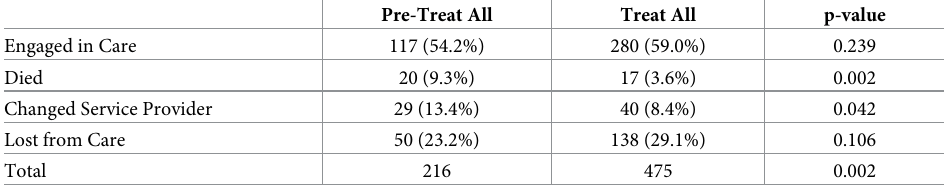
Table 2. Treatment outcomes of patients following ART initiation in the pre- treat-all and treat-all periods, Man- icaland, Zimbabwe, July 2015 to June 2017. Pre-Treat All Treat All p-value Engaged in Care 117 (54.2%) 280 (59.0%) 0.239 Died 20 (9.3%) 17 (3.6%) 0.002 29 (13.4%) 50